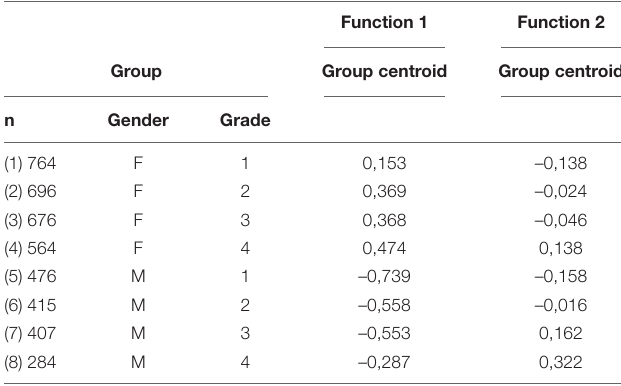
TABLE 5 | Positions of groups centroids on the two significant canonical discriminant functions.